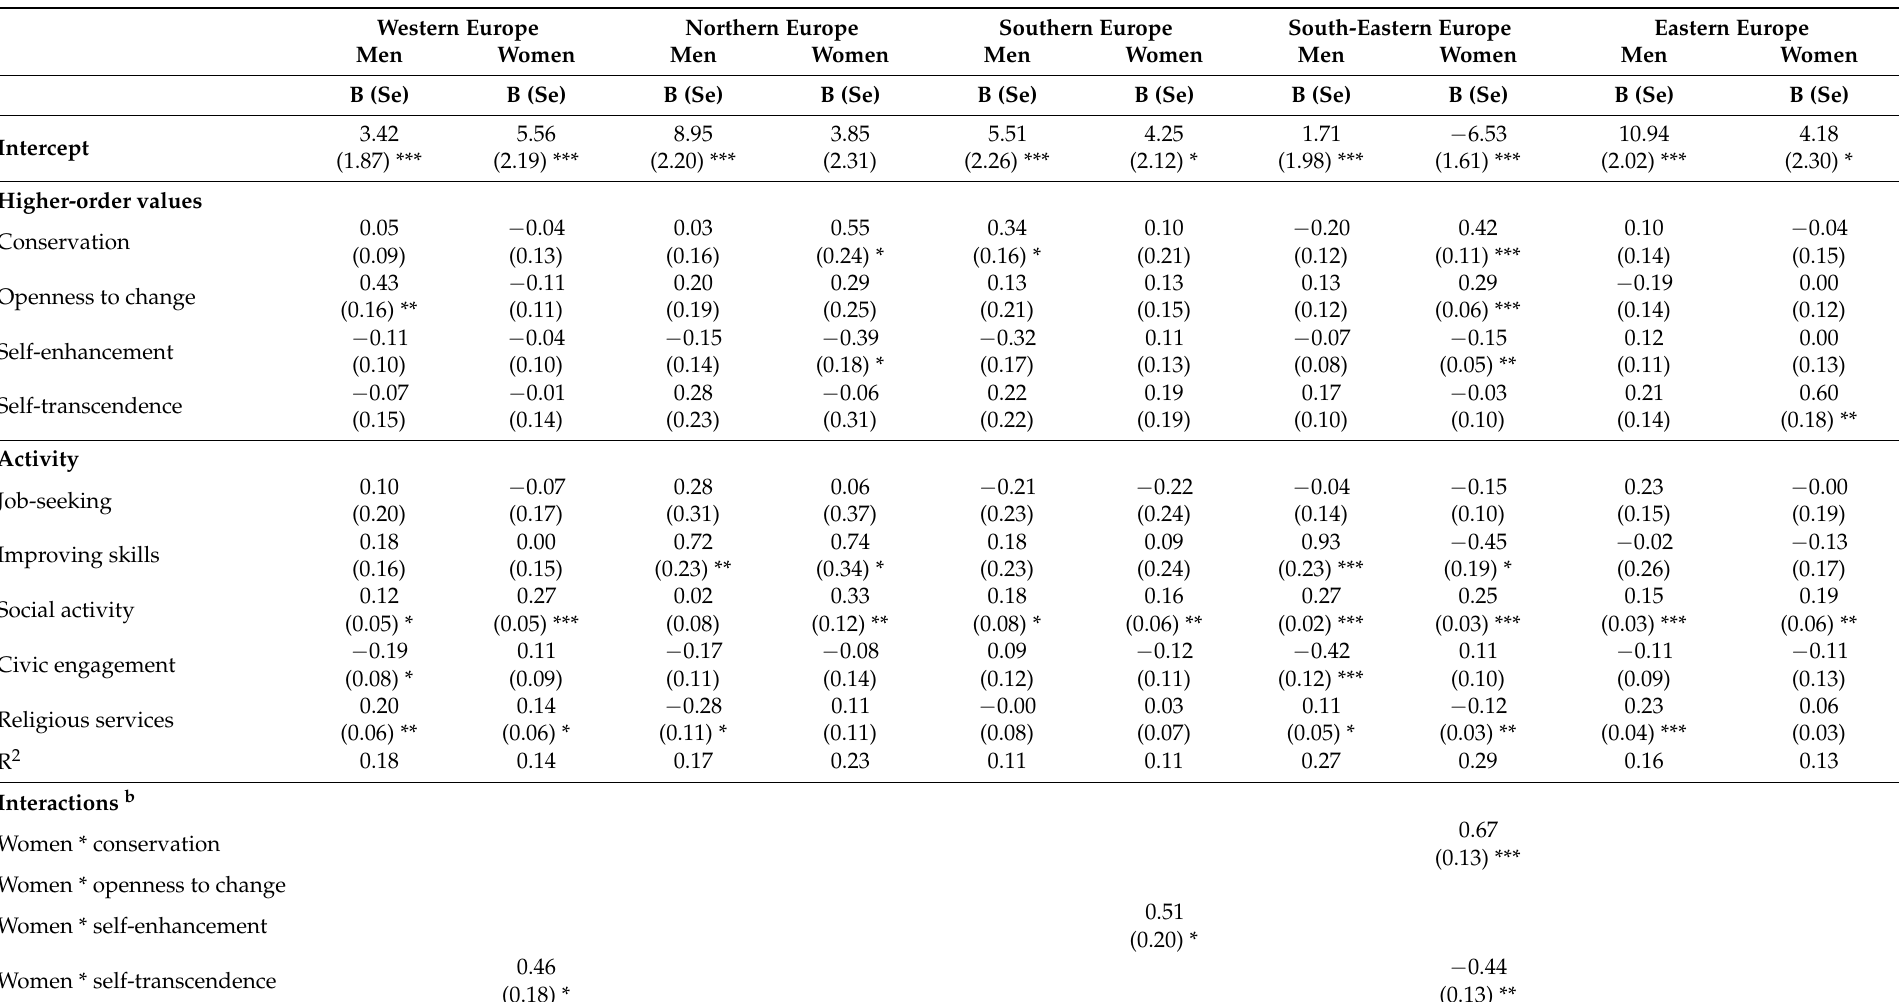
Table 4. Unstandardised betas (standard errors) for the association between SW and values in NEET men and women stratified by European region a . Western